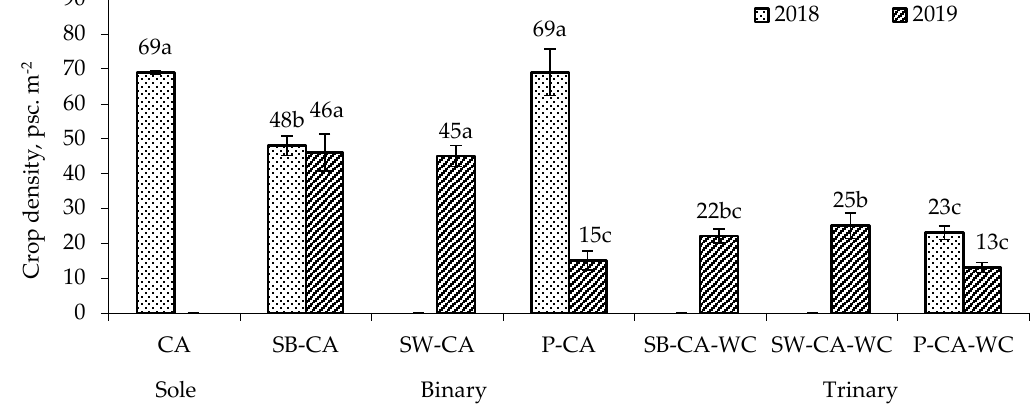
Figure 6. Caraway crop density before harvest in 2018–2019. Note. CA—caraway, SB—spring barley, SW—spring wheat, P—pea, WC—white clover. Differences between the averages of treatments marked with different letters (a, b, c) are significant ( p < 0.05); error bars indicate the standard error.